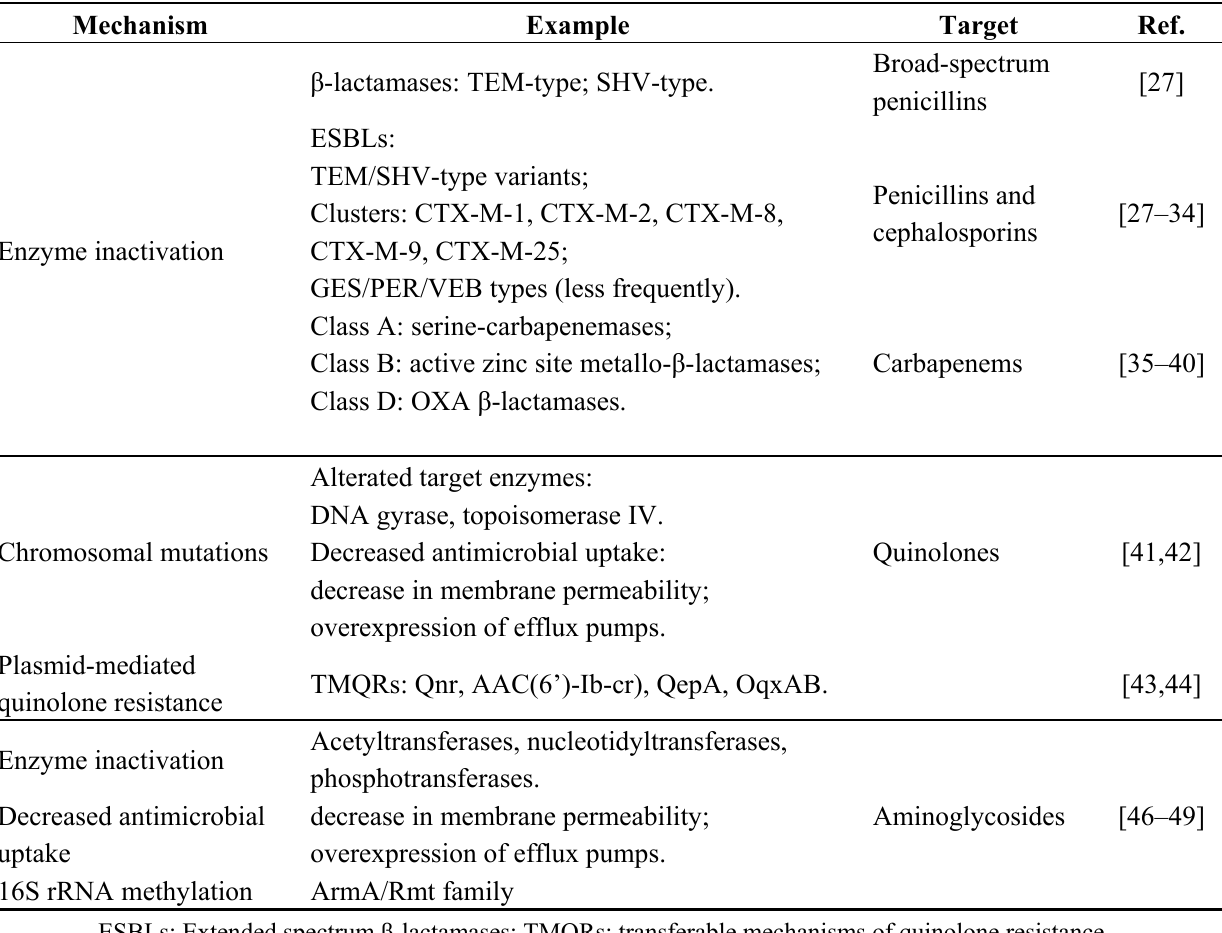
Table 2. Mechanisms of